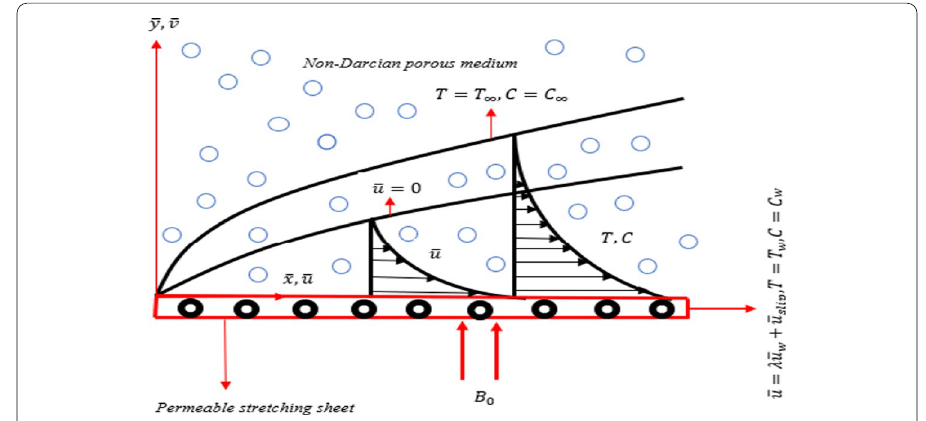
Fig. 1 The physical geometry of the